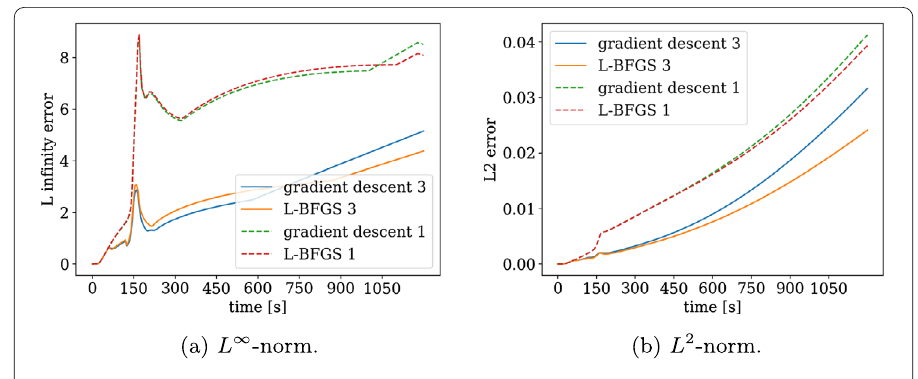
Figure 11 Evolution of the error in temperature over time for 3 noisy